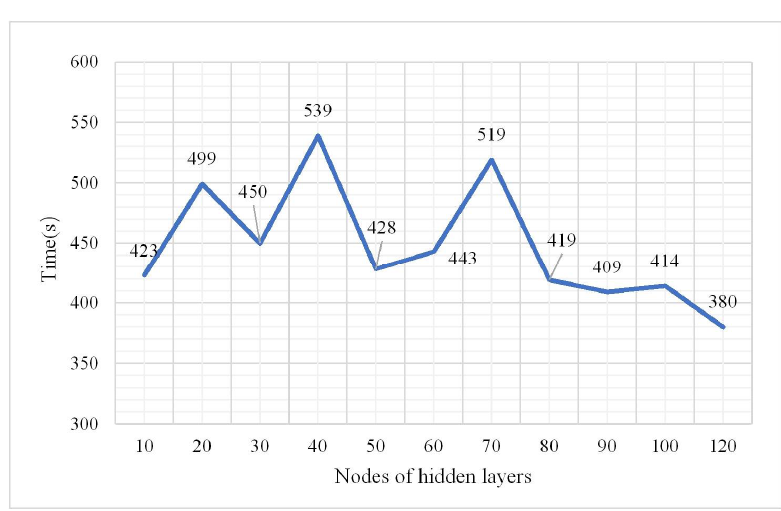
Figure 10. Change in training time.